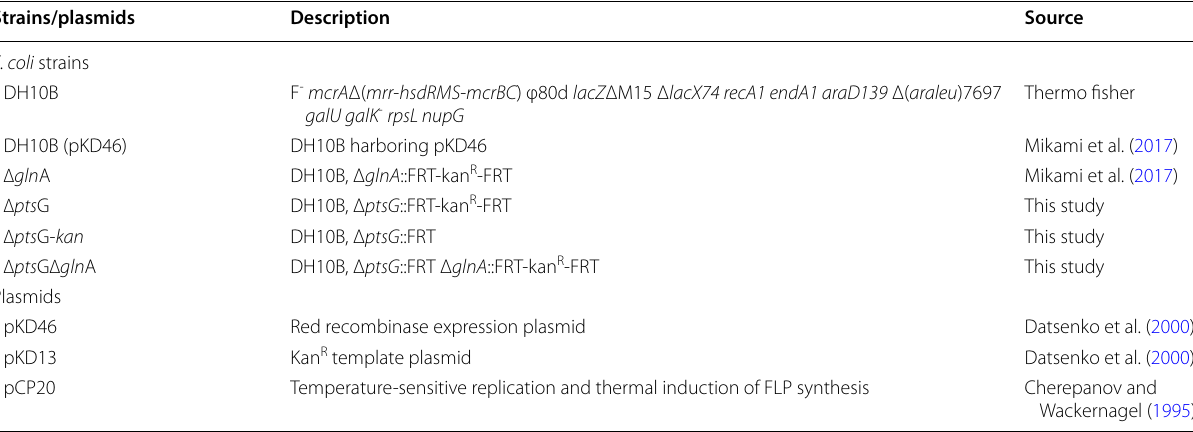
Table 1 E. coli strains and plasmids used in the study